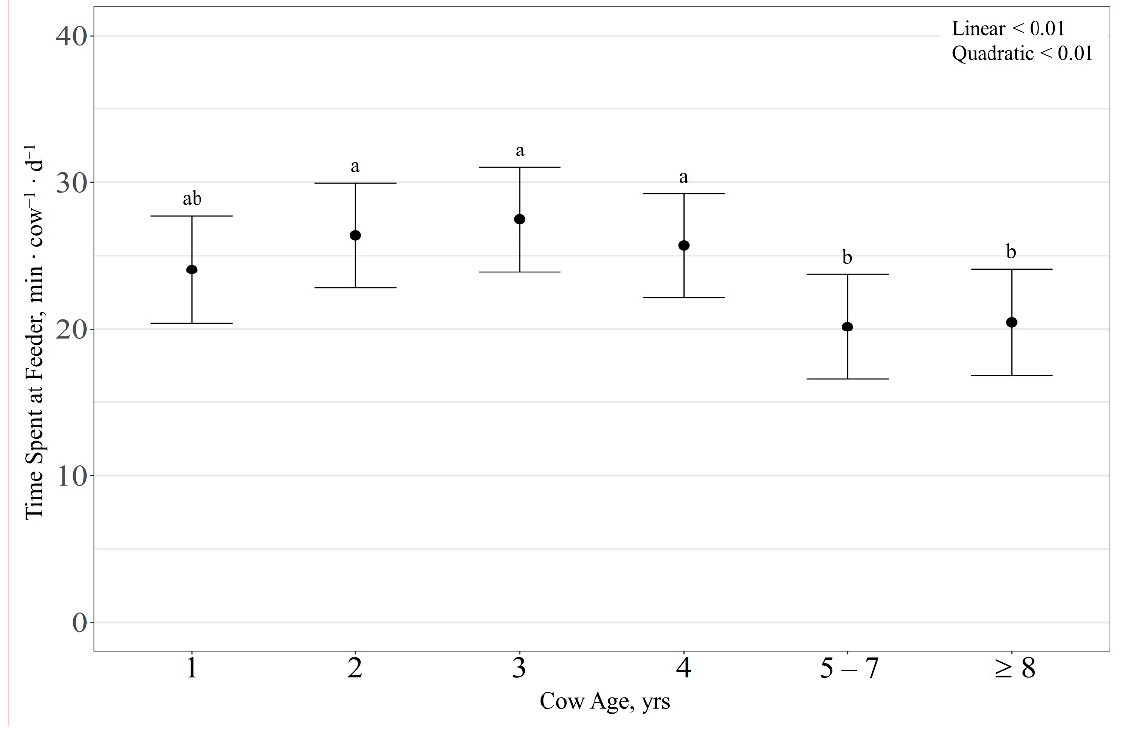
Figure 4. Influence of cow age on average daily time spent at supplement feeder (expressed as minutes · cow − 1 · d − 1 ± SE) by cattle grazing dormant northern mixed-grass prairie in 2018/2019 and 2019/2020 at the Northern Agriculture Research Center’s Thackeray Ranch, Havre, MT, USA. Means lacking common letters (a, b) differ ( p <